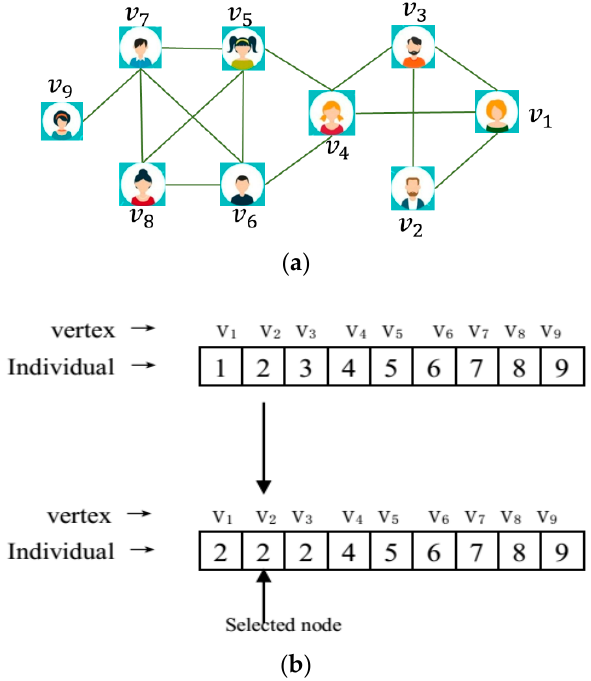
Figure 1. The social network and its representation of an individual with community ID. ( a ) (Color online) A social network of nine actors and 14 connections [45]. ( b ) Select a node randomly and assign its community identifier (ID) to its neighbor nodes.